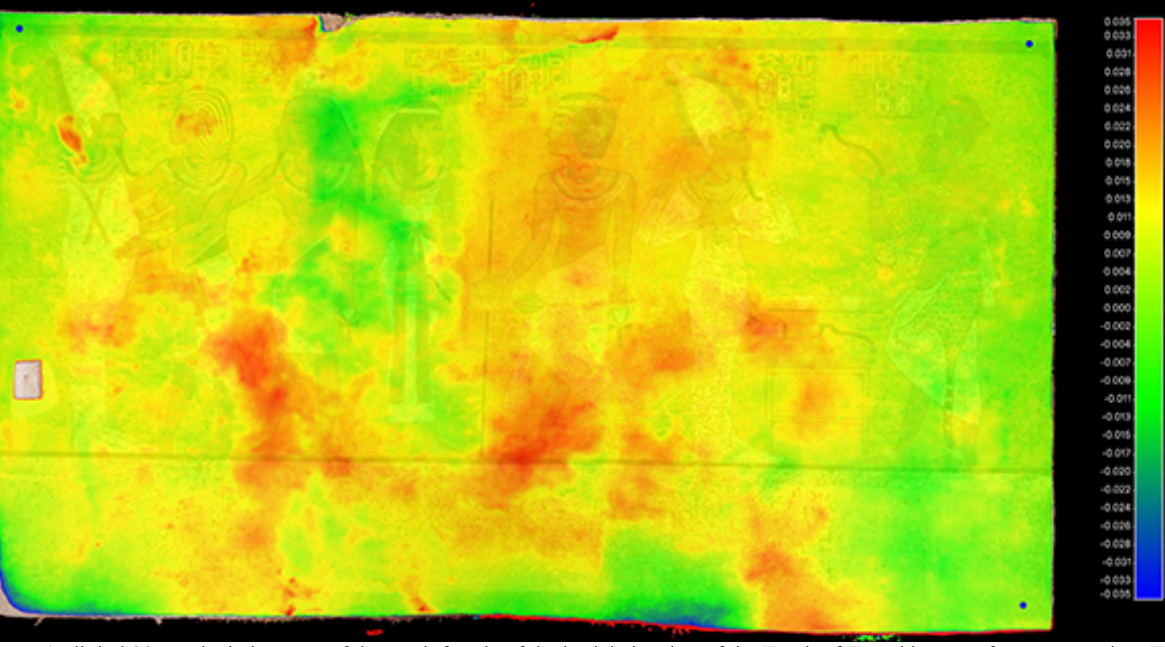
Figure 1: digital 30mm deviation map of the north facade of the burial chamber of the Tomb of Tutankhamen after conservation, The Getty Conservation Institute and Carleton